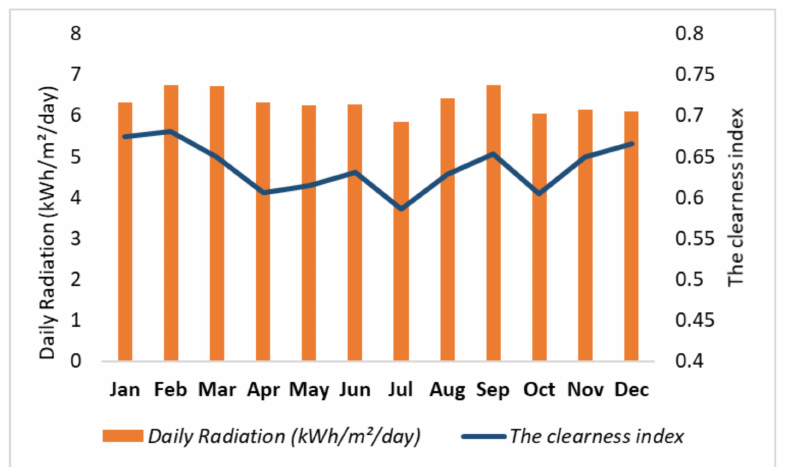
Figure 2. Averaged solar irradiance and clearness index for the selected area from Homer software. Monthly average and hourly wind speed data for the city of Cadaado obtained from NASA are shown in Figures 3 and 4, respectively. It is noticeable that the maximum measured wind speed is in the period of June–August and the average annual wind speed exceeds 8 m/s, and it is the lowest in April. Based on wind speed data, it is proven that in Cadaado, wind energy is available most of the year and can be used to generate energy by reducing the use of diesel